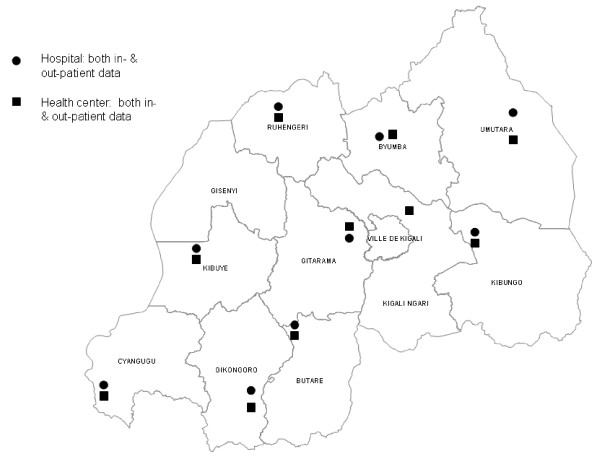
Location of hospitals and health centers that were selected for data collection and had complete data, December 2007, Rwanda.